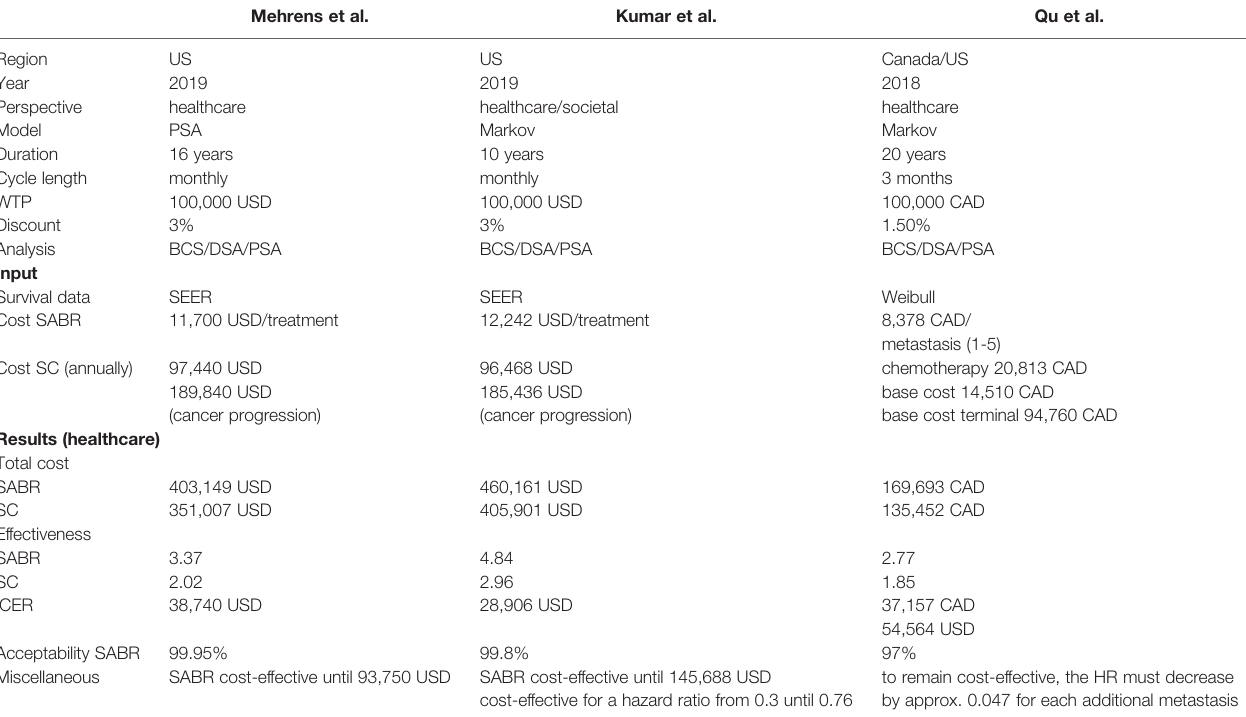
TABLE 3 | Comparison of SABR-COMET cost-effectiveness